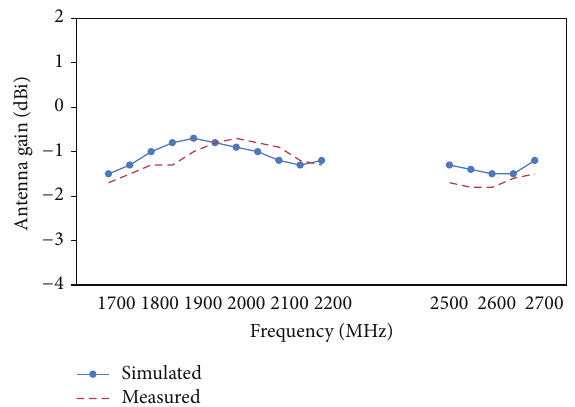
Figure 7: Simulated and measured antenna gain of the proposed antenna at V 1 port.